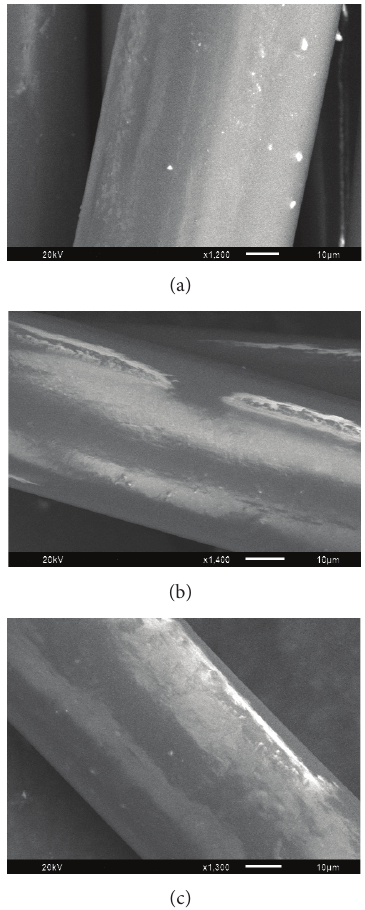
Figure 7: SEM images of irradiated polypropylene fibers at (a) 200 kGy, (b) 250 kGy, and (c)